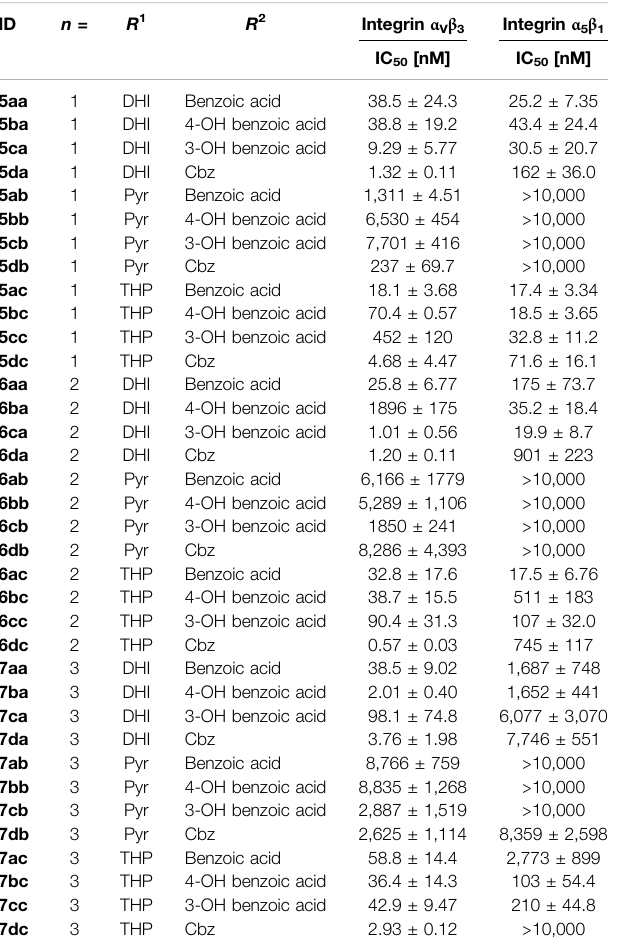
TABLE 4 | Results of the ELISA-like assay with the isolated extracellular domains of integrin α V β 3 and α 5 β 1 . Cilengitide (IC 50 α V β 3 : 0.54 nM; α 5 β 1 : 15.4 nM) was used as reference for all assay plates.